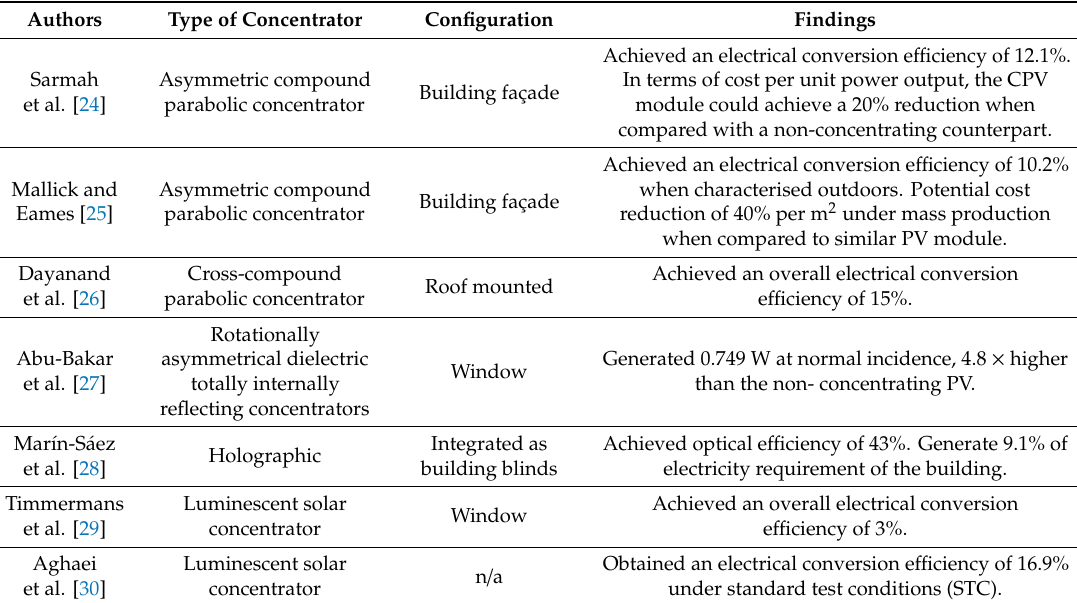
Table 1. Summary of concentrating photovoltaic (CPV)